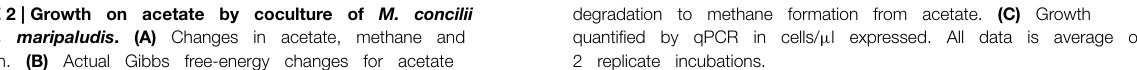
FIGURE 2 | Growth on acetate by coculture of M. concilii and M. maripaludis . (A) Changes in acetate, methane and hydrogen. (B) Actual Gibbs free-energy changes for acetate